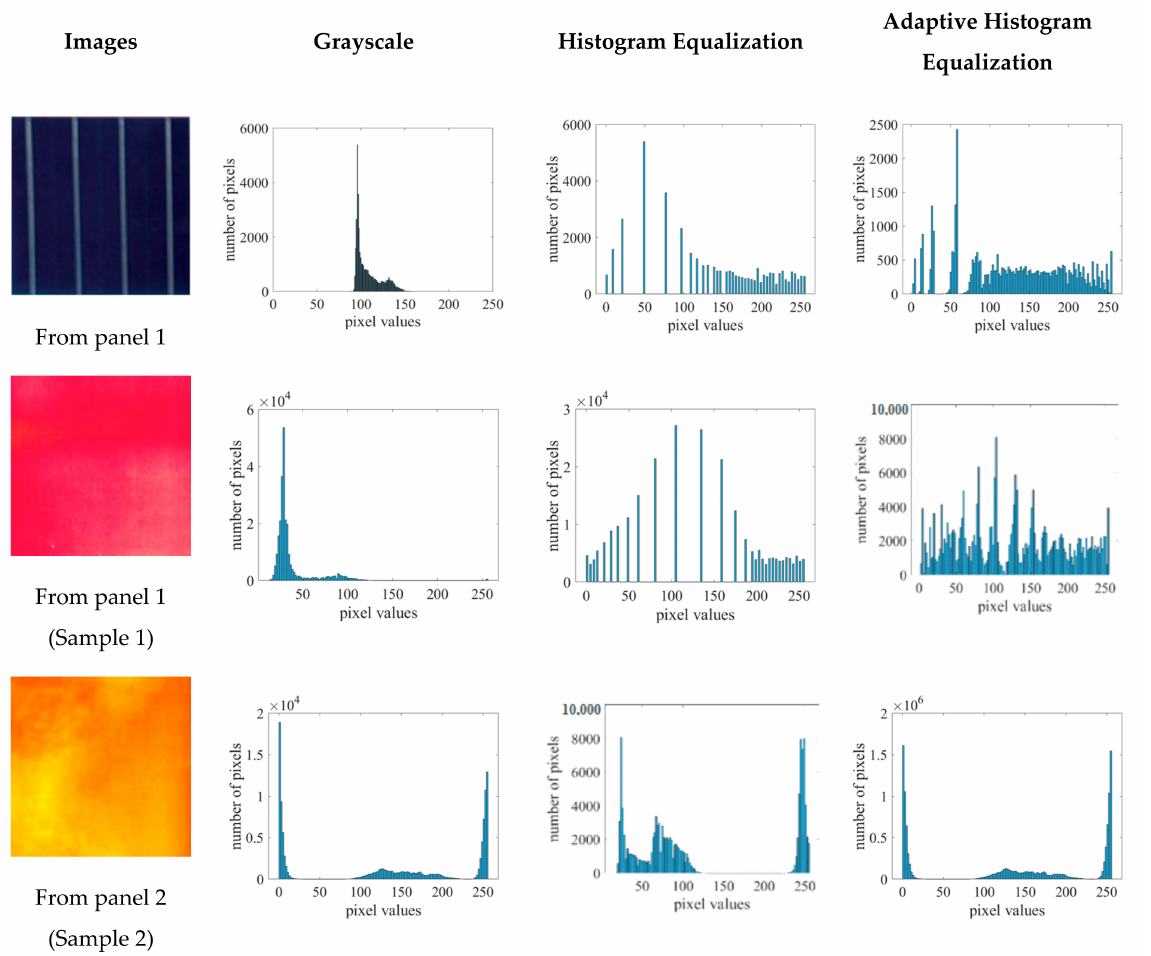
Figure 15. Histogram comparison on the three different images in three different